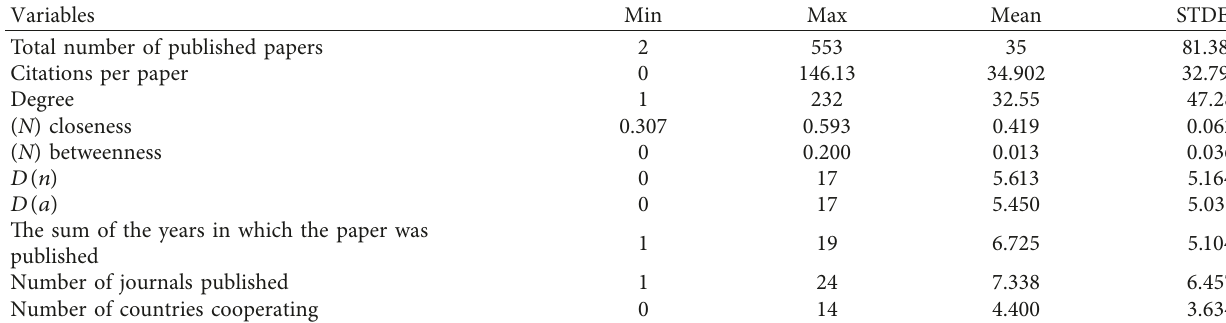
Table 12: Descriptive statistics between